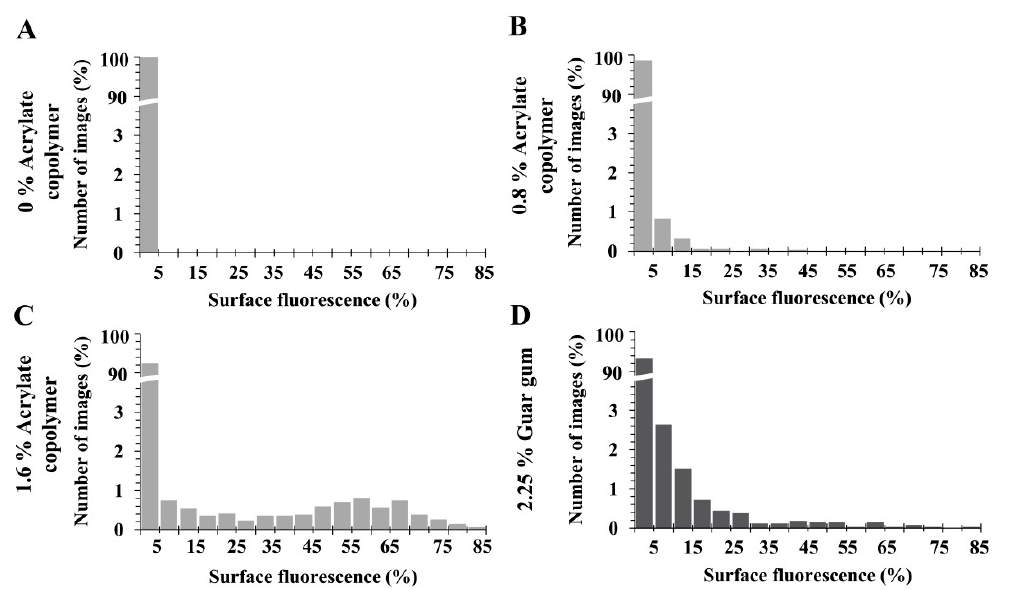
Figure 4. Frequency distribution of surface fluorescence of S. aureus CIP 4.83 in matrices with various concentrations of acrylate copolymer ( A ) 0%, ( B ) 0.8%, and ( C ) 1.6%) or guar gum ( D ) 2.5%.